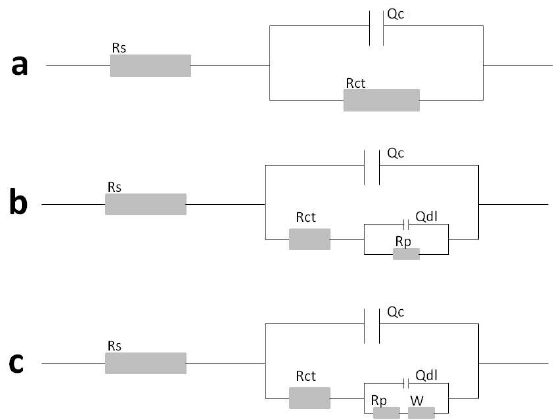
Figure 8. Equivalent electrical circuits.